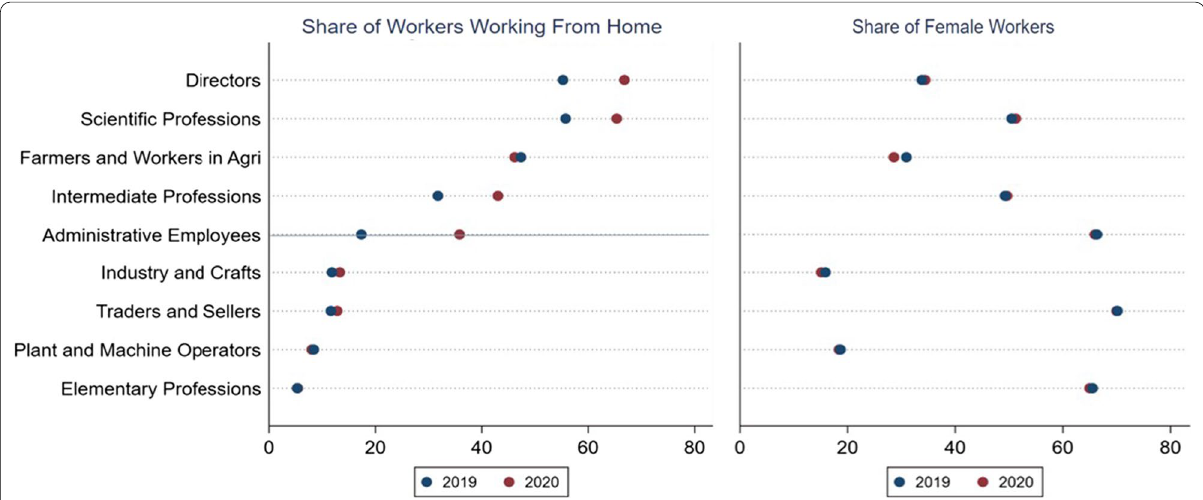
Fig. 6 Telework Availability and Female Share by Occupation. Notes The share of workers working from home (telework availability) is measured as the number of respondents who worked from home in the last 4 weeks as a percentage of the total number of respondents in each occupation group. The share of female workers is calculated as the number of respondents who are female as a percentage of the total number of respondents in each occupation group. We rank occupations in a descending order of telework availability in